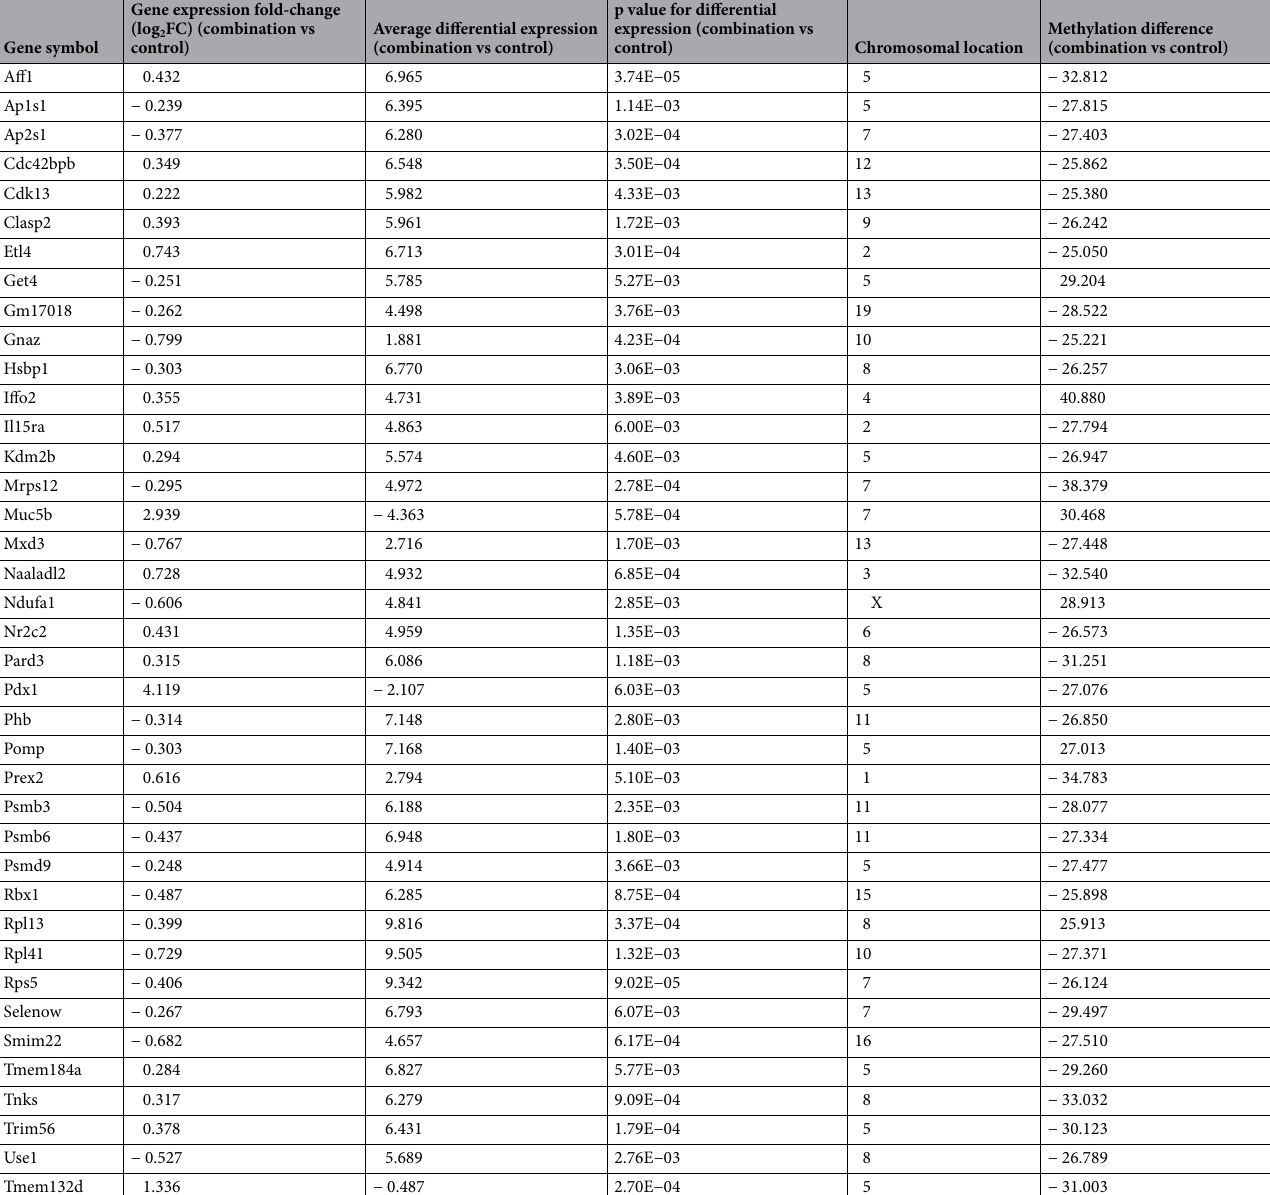
Table 3. Overlapping DEGs with expression level changes and DMGs with methylation level changes in the combination (BSp + GTPs) treatment group.